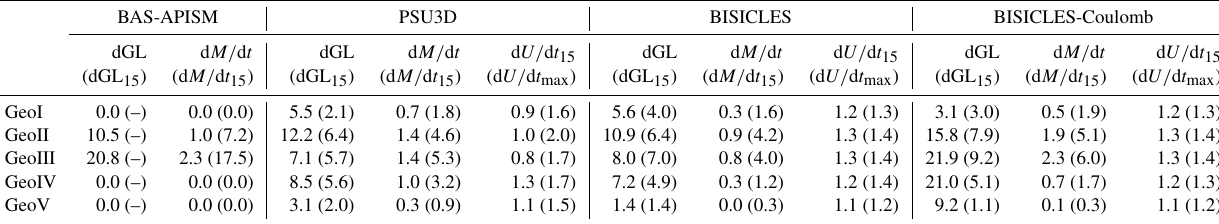
Table A2. Same as for Table A1 but for George VI embayment and Experiment